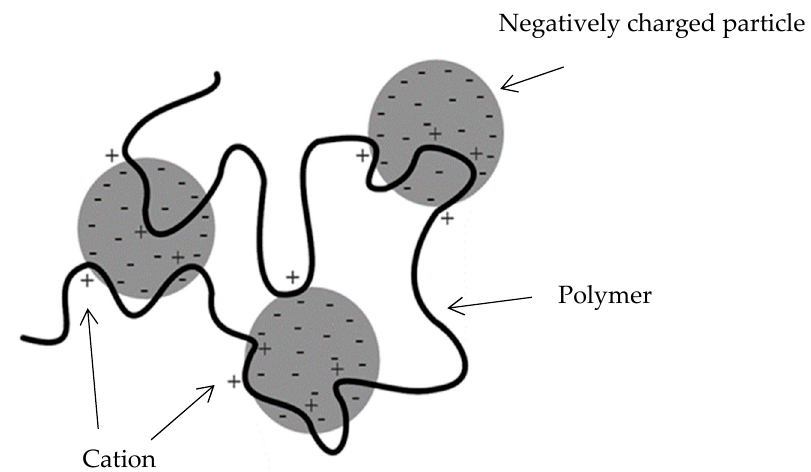
Figure 4. Mechanism of bridging flocculation.